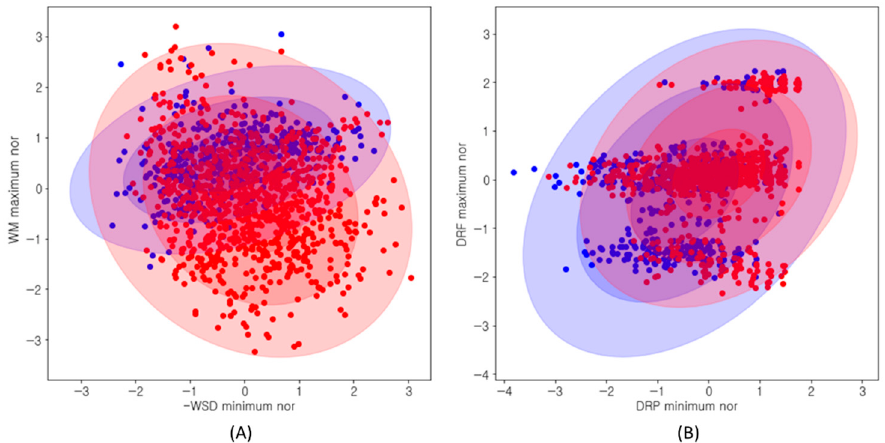
Figure 6. Scatterplot for all subjects. ( A ) Proposed features are used (i.e., WSD and WM), and ( B ) existing features are used (i.e., DRP % and DRF). Here, blue dots represent wake epochs, and red dots represent drowsy epochs. The colored circles are the Gaussian distribution fitted for each label (i.e., drowsy or wake states).